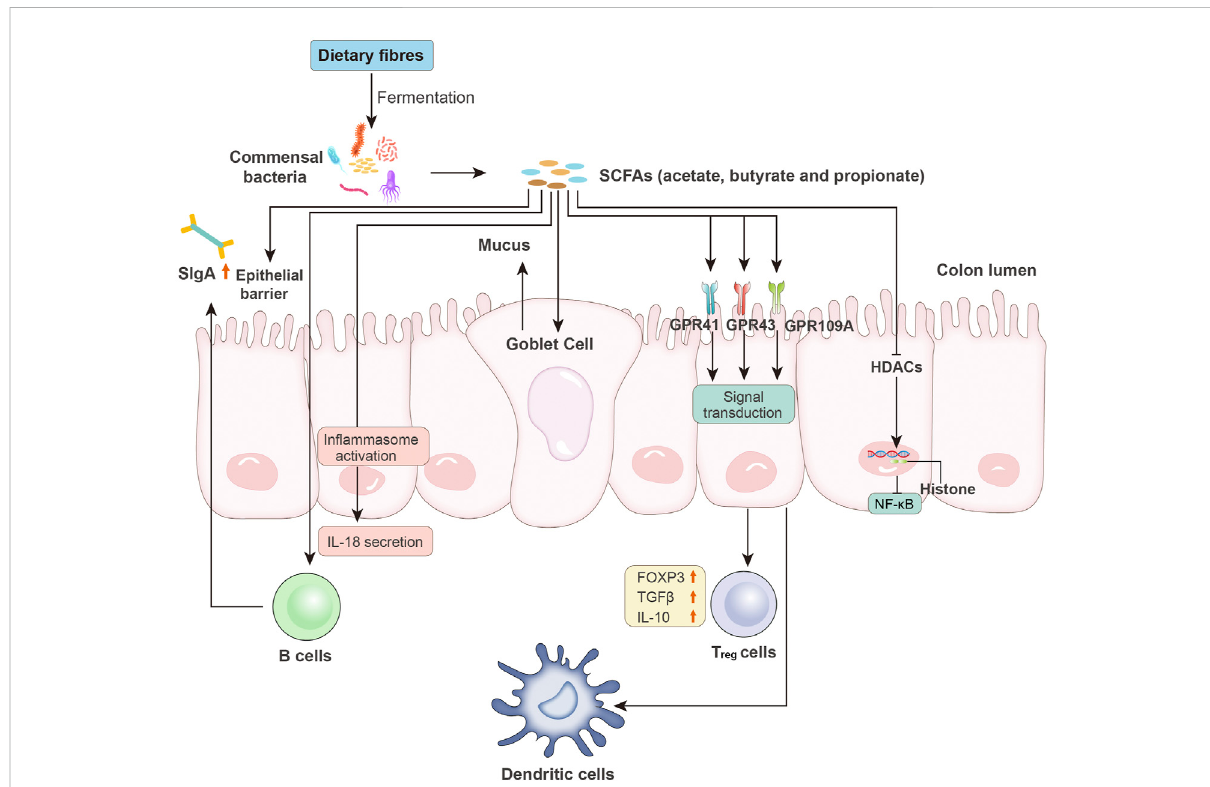
FIGURE 2 Microbiota-derivedSCFAsand intestinal immunity. SCFAs,suchas acetate, butyrate,andpropionate, areproducedbyintestinal bacteria via the fermentation of undigested dietary fi bers. SCFAs affect the host immune system through the following pathways: increased epithelial barrier function; increased B cell-based sIgA secretion; activation of in fl ammasomes and induced production of IL-18; enhanced goblet cell-based mucus production; binding to epithelial surface GPCRs (e.g., GPR41, GPR43, and GPR109A) to reduce expression of T-cell-activating molecules on antigen-presentingcells (e.g.,dendriticcells)andincreasedlevelsofFOXP3andanti-in fl ammatorycytokines(e.g.,TGF- β andIL-10)inT reg cells; and inhibition of HDAC activity, followed by NF- κ B inhibition. sIgA, secretory IgA; GPCRs, G protein-coupled receptors; FOXP3, forkhead box P3; T reg cells, regulatory T cells; HDACs, histone